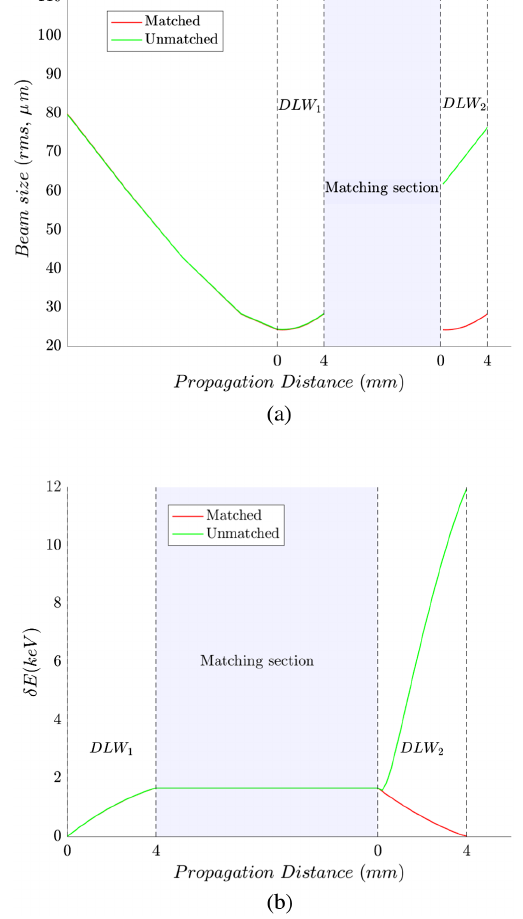
FIG. 8. (a) Beam envelope evolution through an orthogonal two-stage system with and without a pseudoinverse matching between stages. (b) The energy spread profile across a multi- staged system. Entrance and exit of DLWs are marked with vertical dashed lines where the entrance of the first DLW is located at zero.